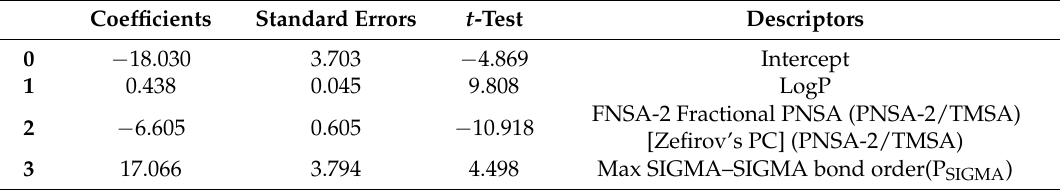
Table 3. Descriptors, Coefficients, Standard Errors, and t -Test Values for the Best MLR Model of Group 2.